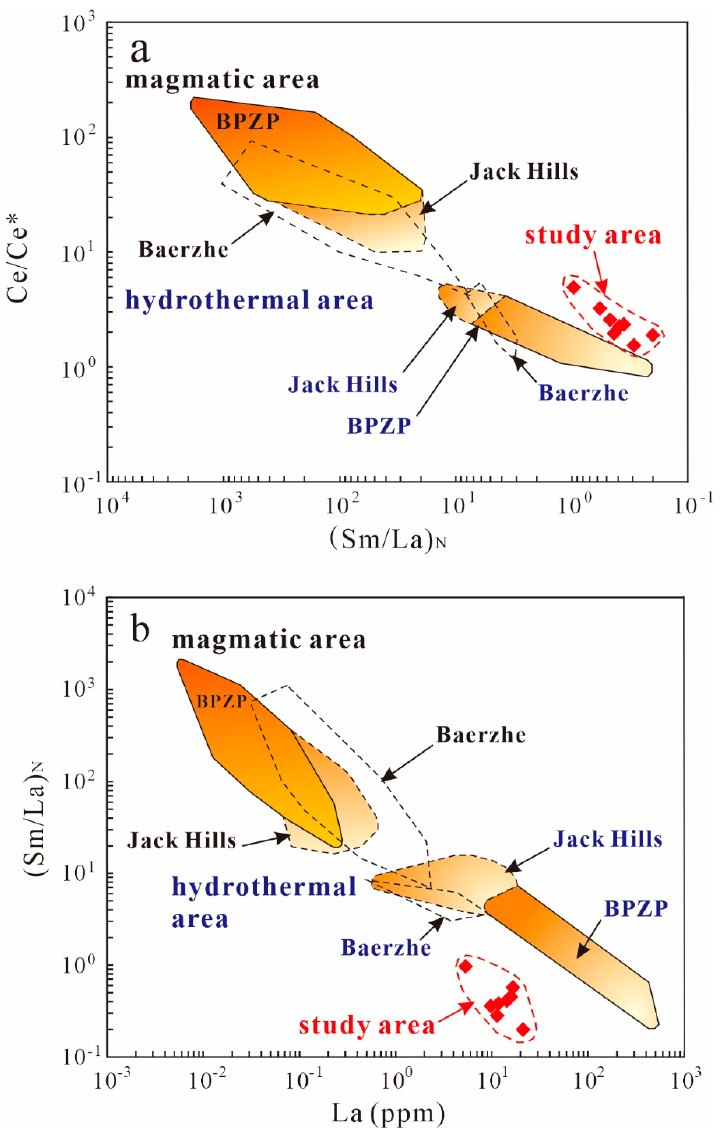
Figure 6. Discriminant diagrams for zircons. ( a ) Ce/Ce* vs. (Sm/La) N ( b ) (Sm/La) N vs. La (ppm) for zircons from the quartz–allanite vein compared to the magmatic and hydrothermal zircons from other areas such as the Boggy Plain Zoned Pluton (BPZP) aplite and Jack Hills Hadean zircon data are taken from Hoskin, 2005 [40]; the Baerzhe alkali granite, Inner Mongolia, NE China, data are taken from Yang et al., 2014 [41].